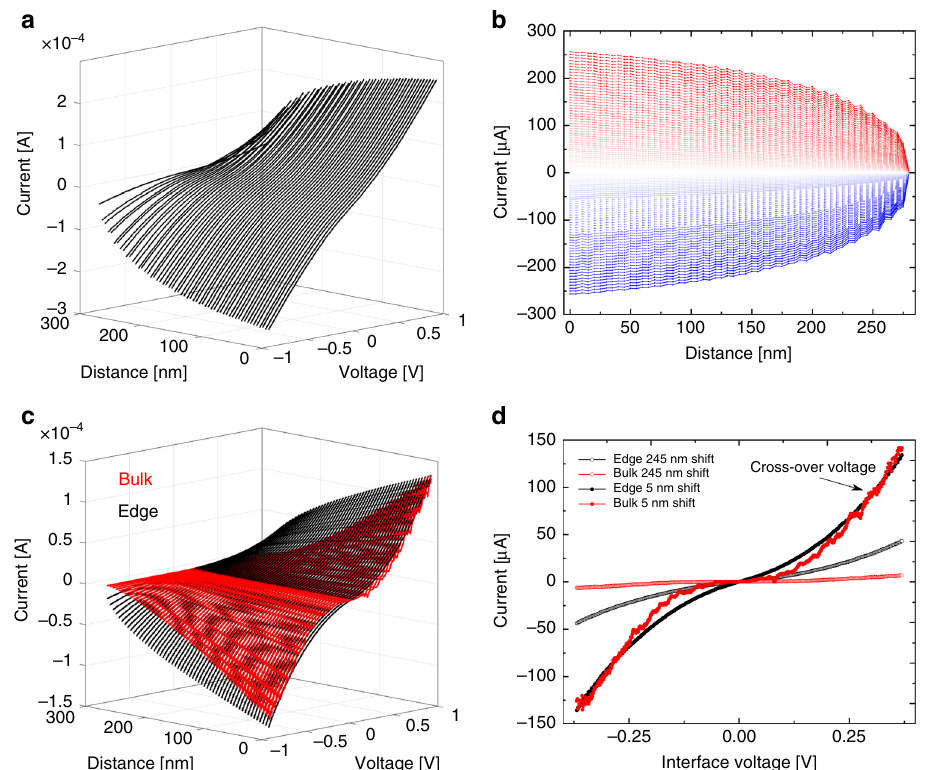
Fig. 2 Reconstruction of the edge and bulk interface conduction vs. applied bias voltage. a 3D diagram of the current vs. voltage pro fi les obtained at different relative sliding positions. b Reconstruction of the current vs. sliding distance for different applied voltages extracted from the data in a . Color code stands for negative to positive bias potential for dark blue to dark red, respectively. c Separated bulk (red) and edge (black) current vs. voltage pro fi les for different relative sliding positions. d Bulk (red) and edge (black) current vs. interface voltage characteristics extracted from c for sliding distances of 5 nm (full circles) and 245 nm (empty circles). The i – V pro fi les for sliding distances of 5 nm (full circles) show a cross-over from edge to bulk dominant transport for interface potentials exceeding 0.3 ± 0.05